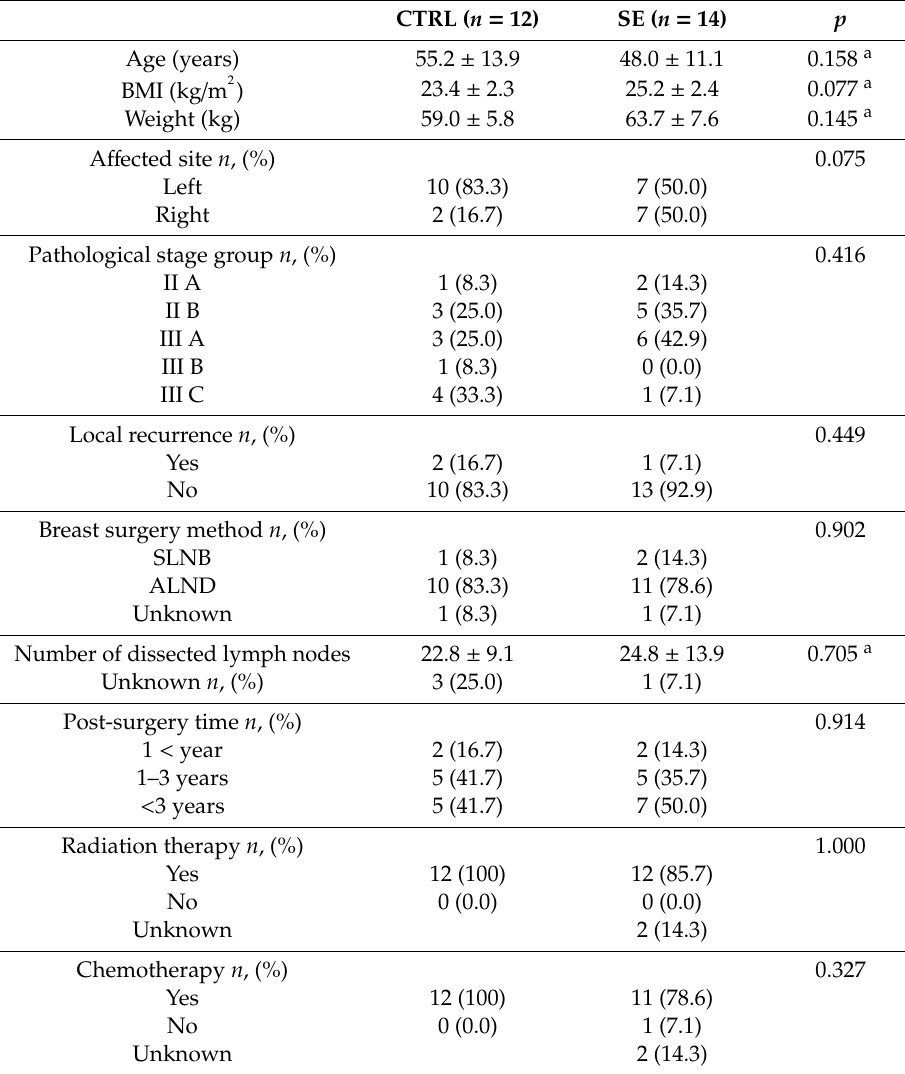
Table 1. Demographic and surgical characteristics of